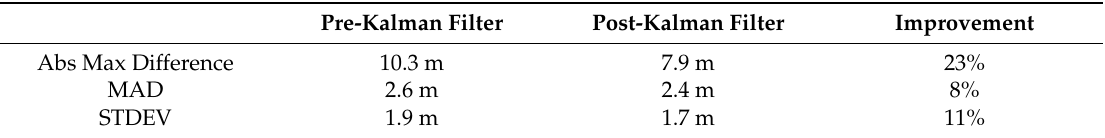
Table 1. Statistical evaluation of elevation differences in respect to the photogrammetric reference